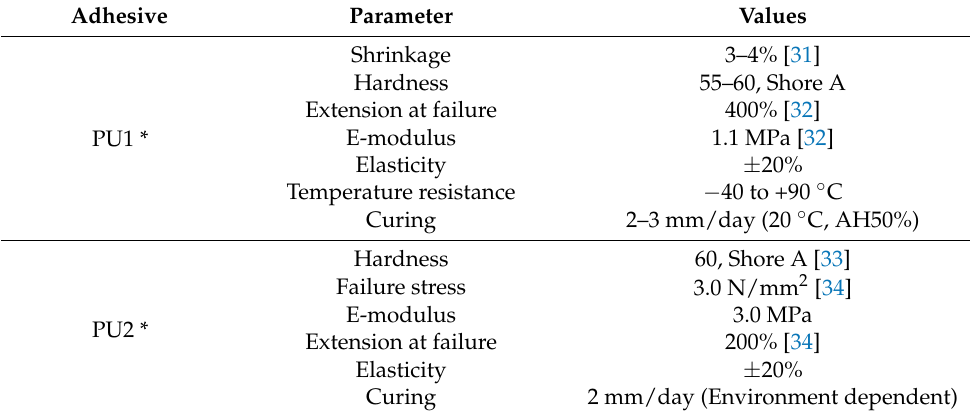
Table 3. Material properties of the flexible